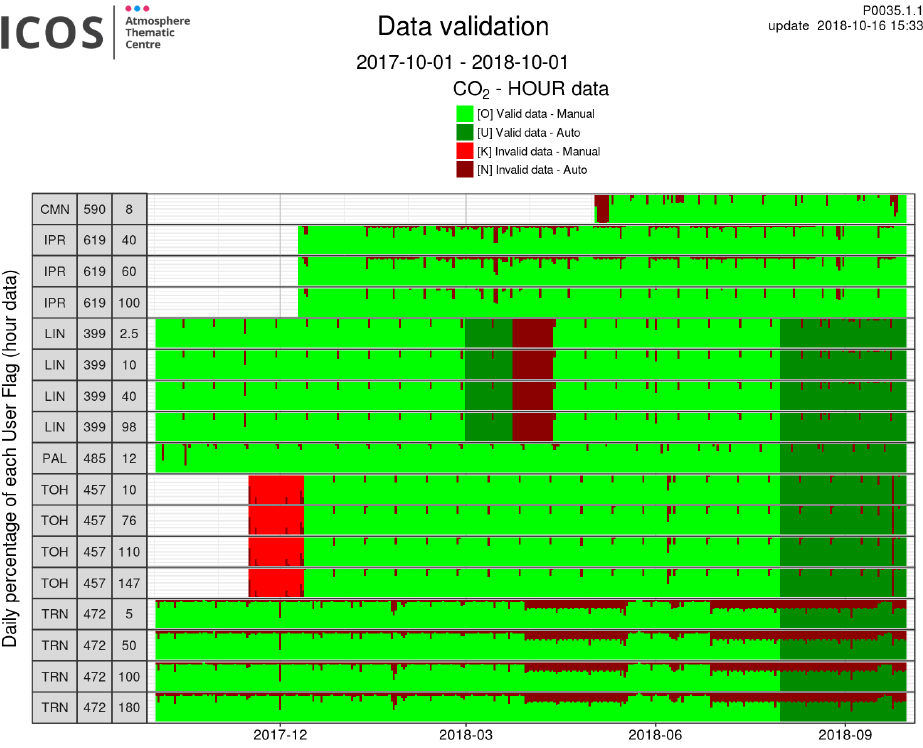
Figure 3. Example of data validation for six stations: CMN (Monte Cimone, Italy), IPR (Ispra, Italy), LIN (Lindenberg, Germany), PAL (Pallas, Finland), TOH (Torfhaus, Germany) and TRN (Trainou, France). Dark colored data are data controlled by the software only. Light colored data are controlled by the PI. Green is valid and red invalid. On the left, the first column shows the station acronym, the second column the ICOS ID of the instrument and the third the sampling height.